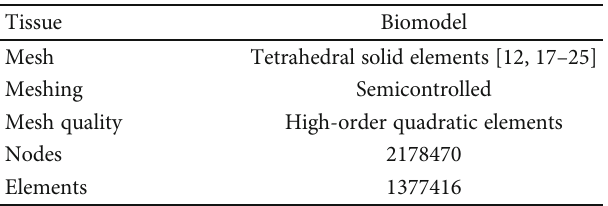
Figure 8: Discretization of the patient ’ s biomodel with brackets and wires in place, prior to performing the numerical analysis. Table 1: Characteristics of the biomodel.